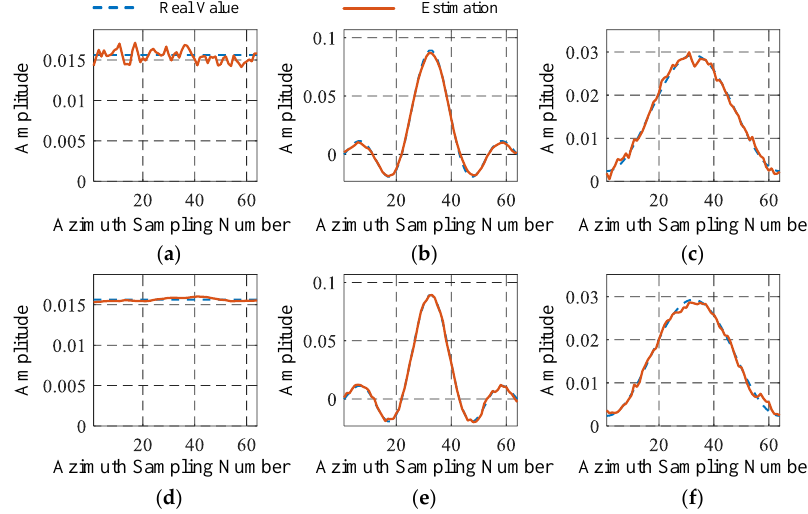
Figure 7. The comparison of the estimations from different methods (signal-to-noise ratio (SNR) = 10 dB). ( a ) Solution of (13) for the constant amplitude function. ( b ) Solution of (13) for the Sinc-like amplitude function. ( c ) Solution of (13) for the hamming-window amplitude function. ( d ) Iterative re-weighted Tikhonov regularization (IRWTR) solution for the constant amplitude function. ( e ) IRWTR solution for the Sinc-like amplitude function. ( f ) IRWTR solution for the hamming-window amplitude function. Remote Sens. 2018 , 10 , x FOR PEER REVIEW